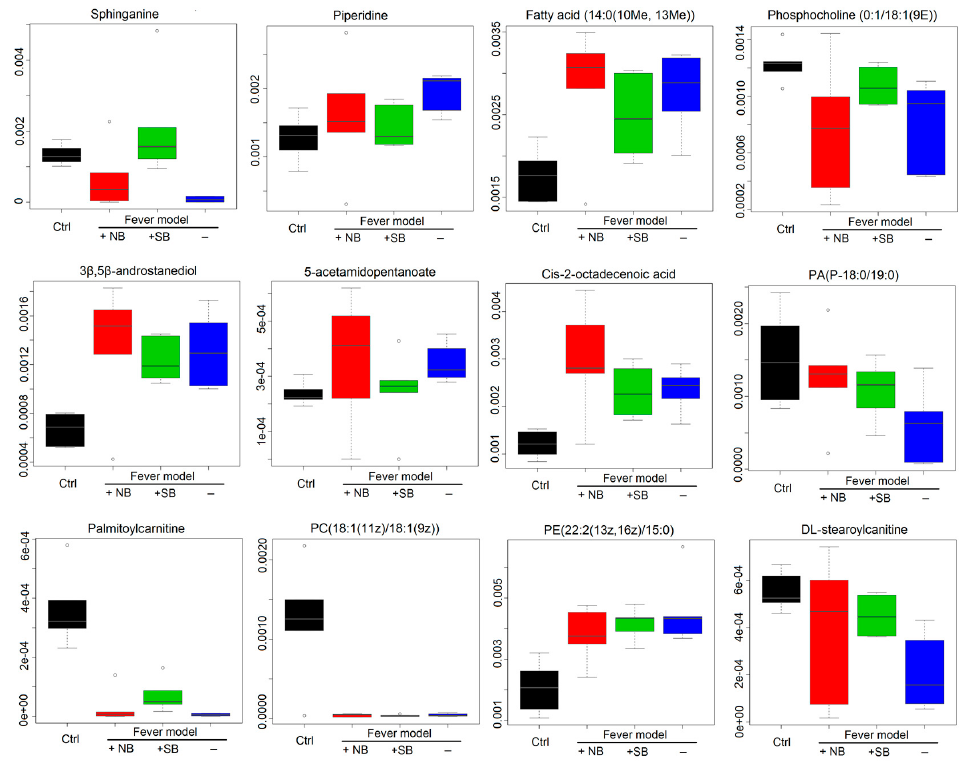
Figure 7. Boxplots of identical biomarkers. The vertical axis represents the chromatography peak intensity of each biomarker in UPLC-Q-TOF/MS analysis normalized to that of the chosen reference peak with the maximum peak area.